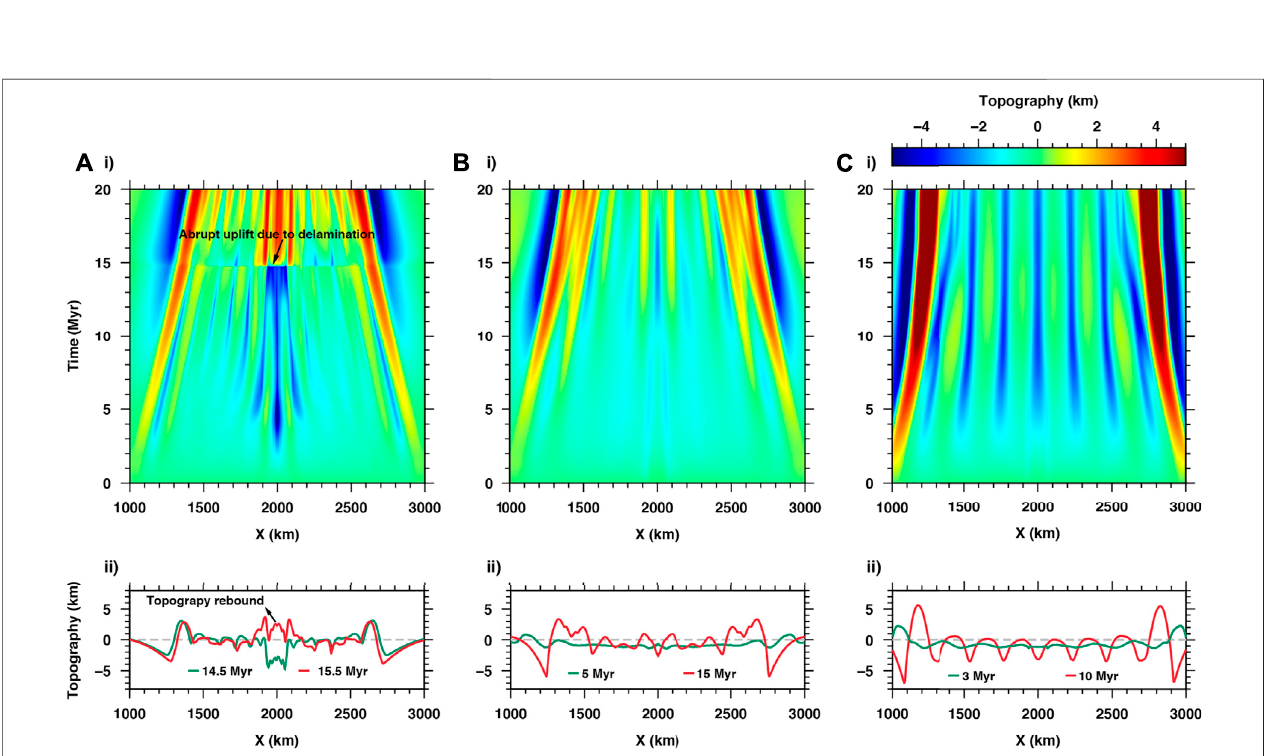
FIGURE 6 | Comparison among the topography developments predicted by the weak, intermediately strong, and strong lower crust models. (Ai,ii) topography evolutionpredictedby “ dela ” ,inwhich “ diorite ” isusedastheorogenlowercrust fl owlaw. (bi,ii) topographyevolutionpredictedby “ delc ” ,inwhich “ plagioclase ” isused as the orogen lower crust fl ow law. (ci,ii) topography evolution predicted by “ delf ” , in which “ diabase ” is used as the orogen lower crust fl ow law.